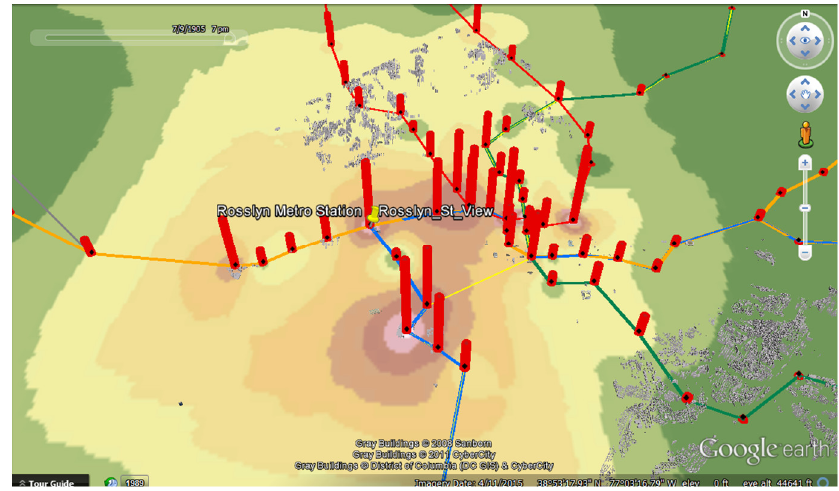
Figure 10. Metro ridership in Washington, D.C. region. Red bars represent location of transit stations